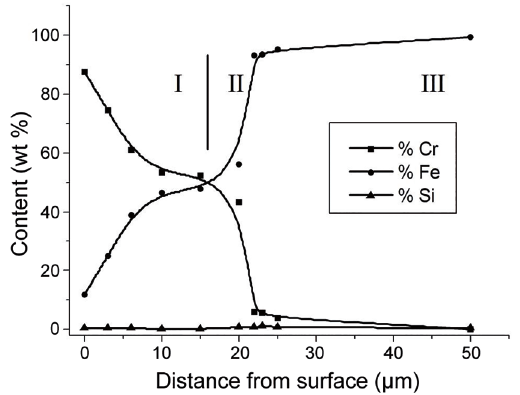
Figure 3: Concentration profiles of chromium, iron and silicon (by EDS) in the cross section of a sample chrome–boronizing–siliconizing (obtained using the mixture 3).